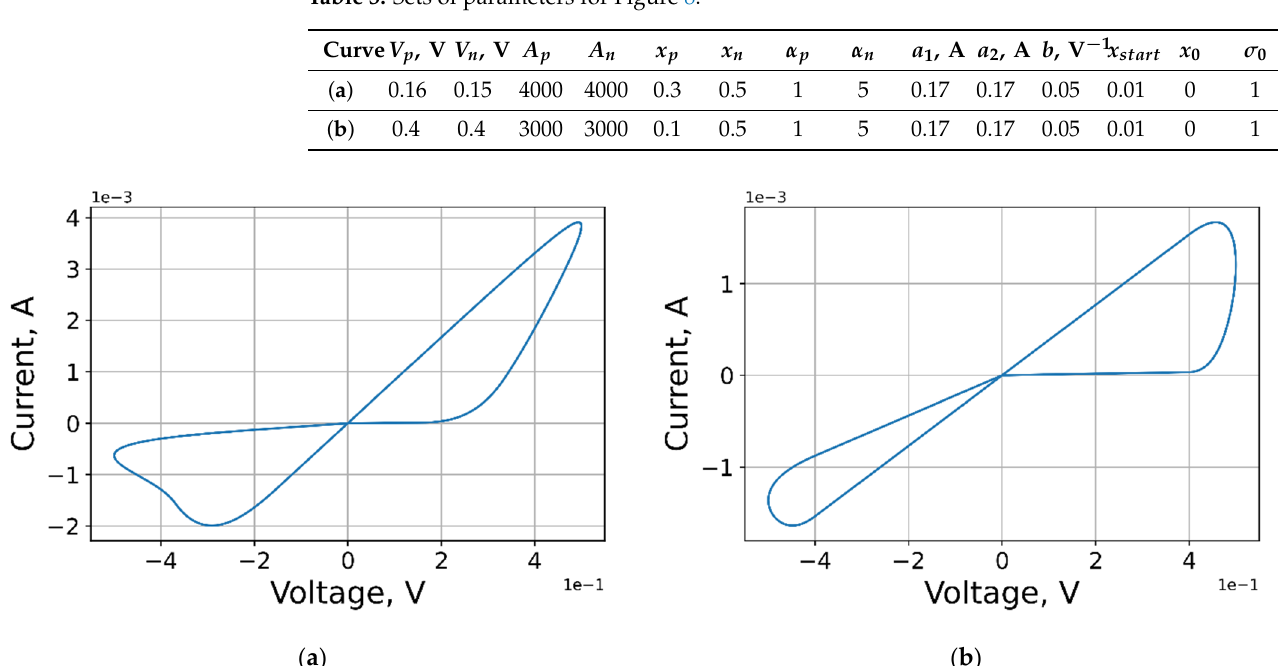
Figure 8. Examples of VACs from the dataset with parameters in: ( a ) (a) row in Table 3; ( b ) (b) row in Table 3 . Table 3. Sets of parameters for Figure 8. Curve